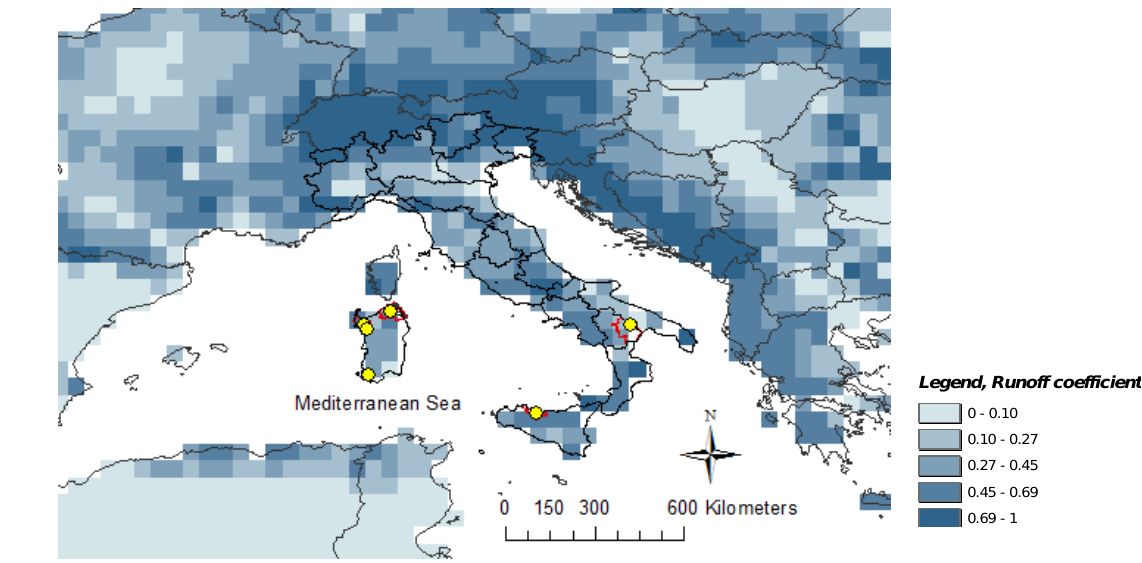
Figure 3. Map of the runoff coefficient obtained as the ratio of total runoff to total precipitation values with irrigation districts (red perimeters, legend in Figure 2) and reservoirs (yellow points, legend in Figure 2). Values were validated around study areas by comparing observed and modelled data (Table 2).